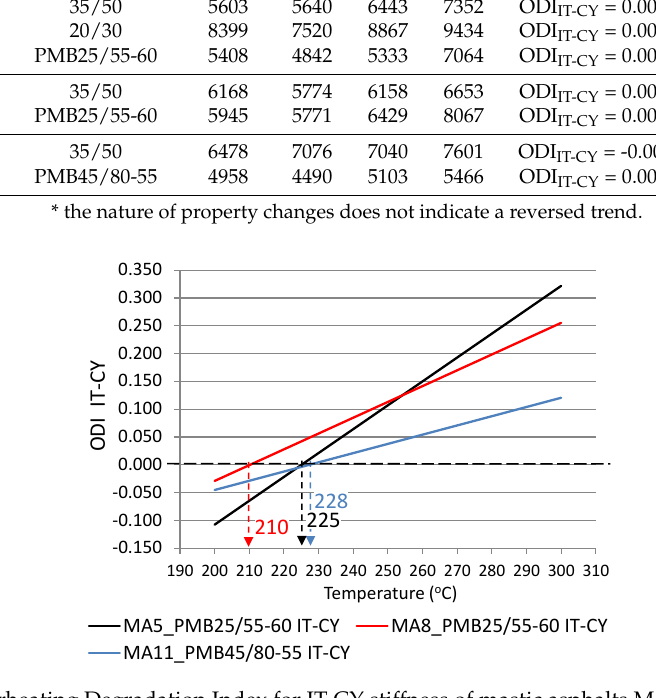
Figure 11. Overheating Degradation Index for IT-CY stiffness of mastic asphalts MA5, MA8 and MA11 with modified bitumens and determination of temperature T (ODI) .